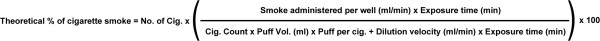
Equation for calculating theoretical smoke dose [[18]].